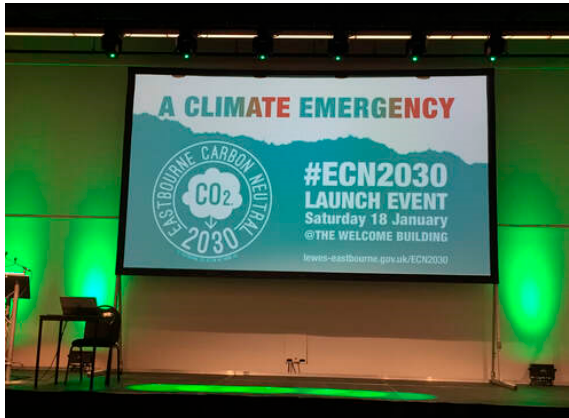
Figure 5. Carbo Neutral 2030 Launch event, Welcome Building, Eastbourne, 18 January 2020 @UNA Eastbourne.